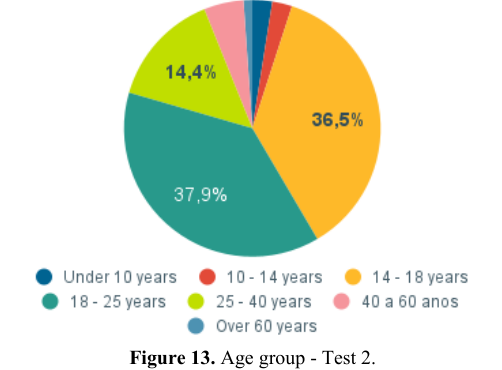
Figure 17. Do you have the habit of playing video games? - Test 2.